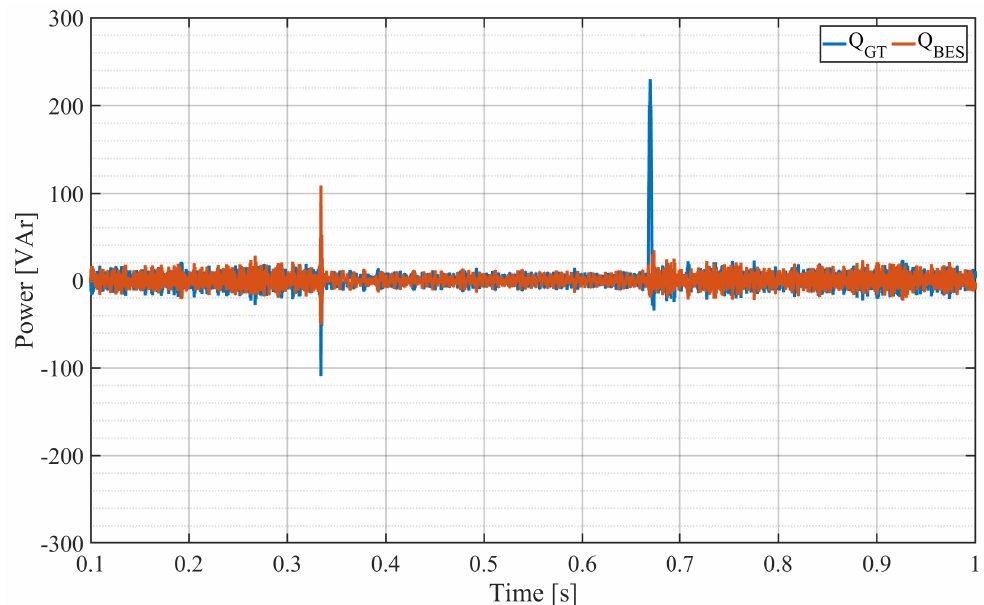
Figure 10. Reactive power measurement during one second simulation.